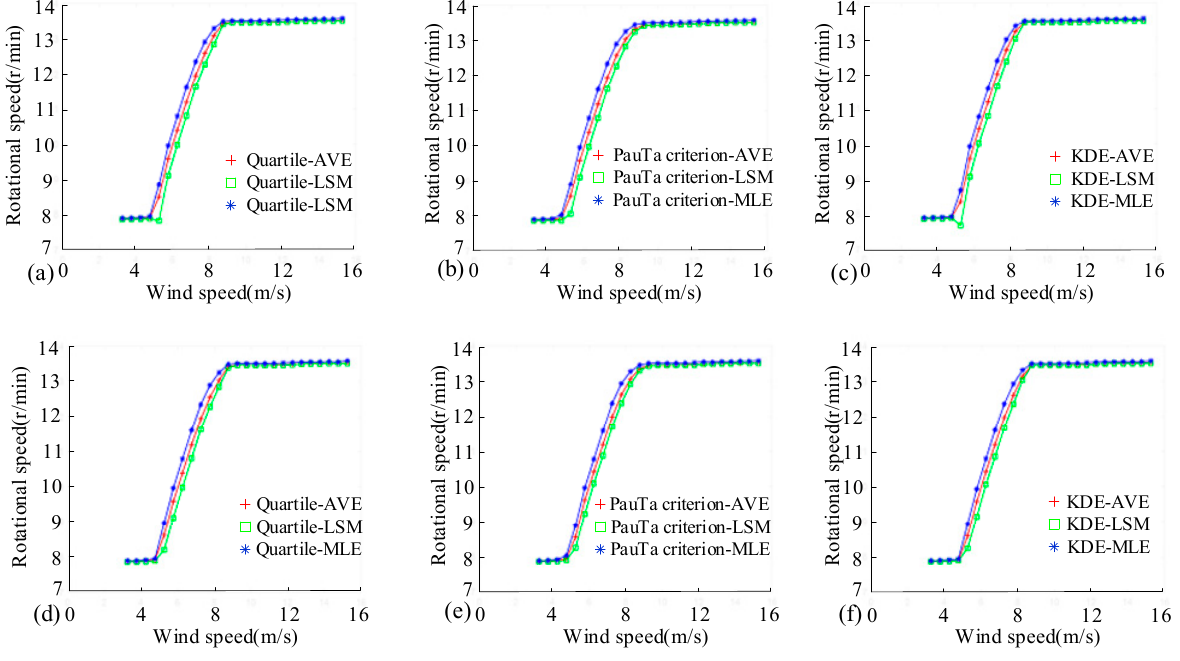
Figure 13. Influence of sliding Binning mode on wind–rotational speed curve. ( a ) wind speed and rotational speed curves obtained by selecting DSB mode using three Quartile-based methods; ( b ) wind speed and rotational speed curves obtained by selecting DSB mode using three PauTa-based methods; ( c ) wind speed and rotational speed curves obtained by selecting DSB mode using three KDE-based methods; ( d ) wind speed and rotational speed curves obtained by selecting SSB mode using three Quartile-based methods; ( e ) wind speed and rotational speed curves obtained by selecting SSB mode using three PauTa-based methods; ( f ) wind speed and rotational speed curves obtained by selecting SSB mode using three KDE-based methods. Table 4. Indicators of two kinds of sliding Binning modes.